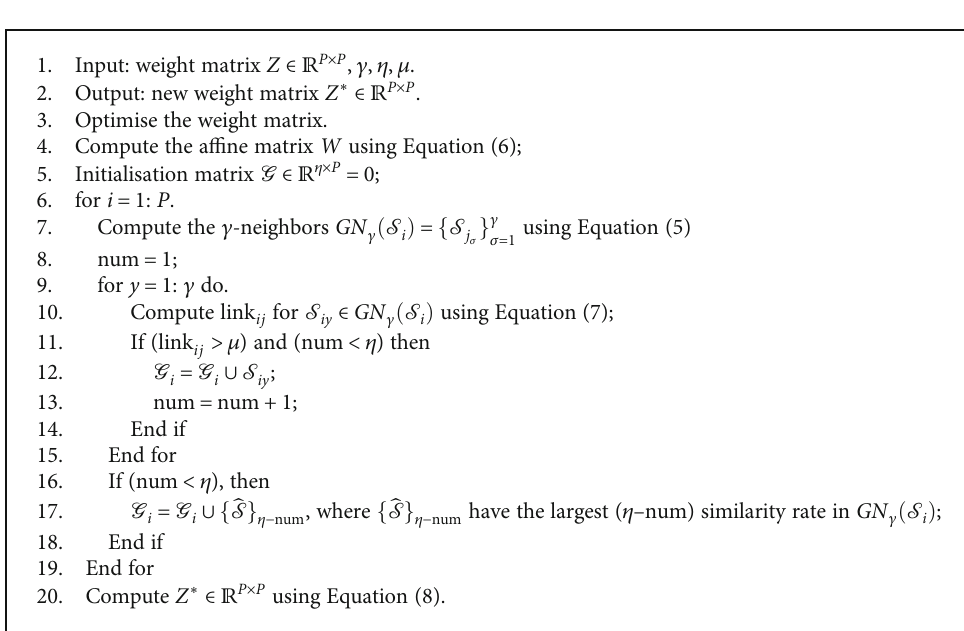
Algorithm 2: Optimisation of weight